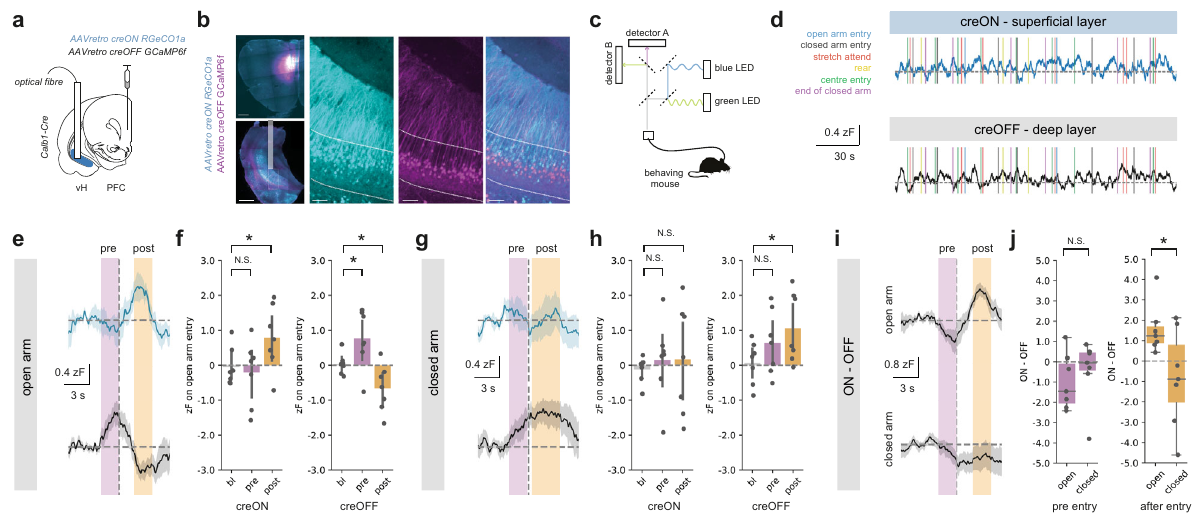
Fig. 5 Super fi cial and deep vH-PFC neuron activity differs during arm entry in the EPM. a Strategy to record super fi cial and deep vH-PFC neuron calcium dynamics during free behaviour. b Left, example images of the viral strategy implemented for imaging. Left, injection of retrograde calcium sensors in PFC (top) and photometry fi bre implant in vH (bottom). Scale bars = 500 µ m. Right, zoom of creON RGeCO1a (cyan) and creOFF GCaMP6f (magenta) calcium sensor expression in the super fi cial and deep layers of vH, respectively. Scale bars = 100 µ m. Images representative of slices from 7 mice. c Light path and recording setup for dual signal detection during free behaviour, allowing simultaneous detection of super fi cial and deep layer activity, see also Supplementary Fig.9. d Example traces of creON (super fi cial layer) and creOFF (deep layer) calcium signal while a mouse is behaving during EPM exploration. e Summary traces of super fi cial (top, blue) and deep ( bottom , grey) layer activity aligned to open arm entry (dashed line) during EPM exploration. Activity periods pre (magenta) and post (orange) arm entry are highlighted for subsequent quanti fi cation. f Summary of peri-event normalized calcium-dependent fl uorescence recorded from super fi cial layer (creON) and deep layer (creOFF) cells during the baseline (bl; – 6 s to – 5 s before arm entry), pre and post arm entry periods for open arm entries. Super fi cial (creON) neurons increase activity on open arm entry (Repeated measures ANOVA, Main effect of epoch: F (2,12) = 4.52, * p = 0.034; planned two-sided Welch ’ s paired t-test with Holm- Š idák correction: bl vs. pre: t (6) = 0.3, N.S. p = 0.77; bl